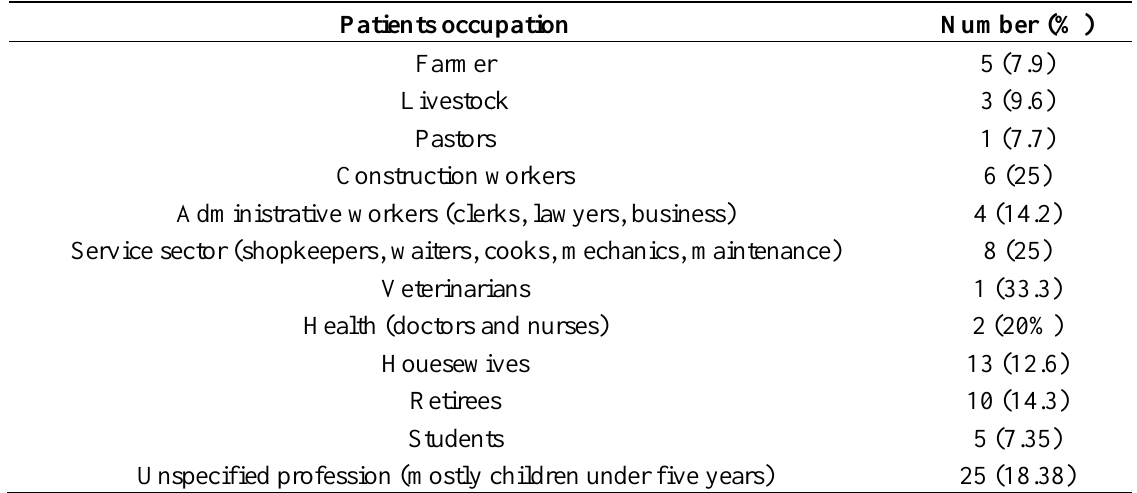
Table 2. Seroprevalence in terms of patient